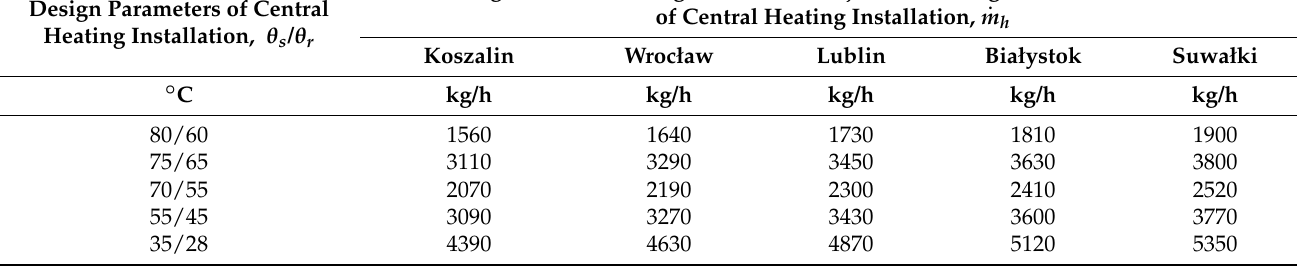
Table 4. The heating medium flow for particular building locations and heating system parameters. Design Parameters of